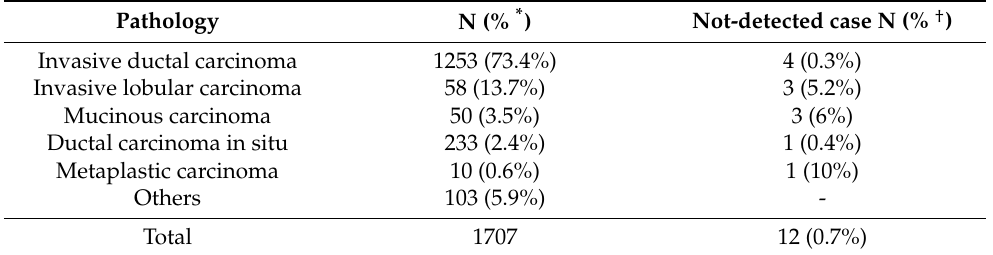
Table 1. Frequency of not-detected breast malignancy in DCE MR according to